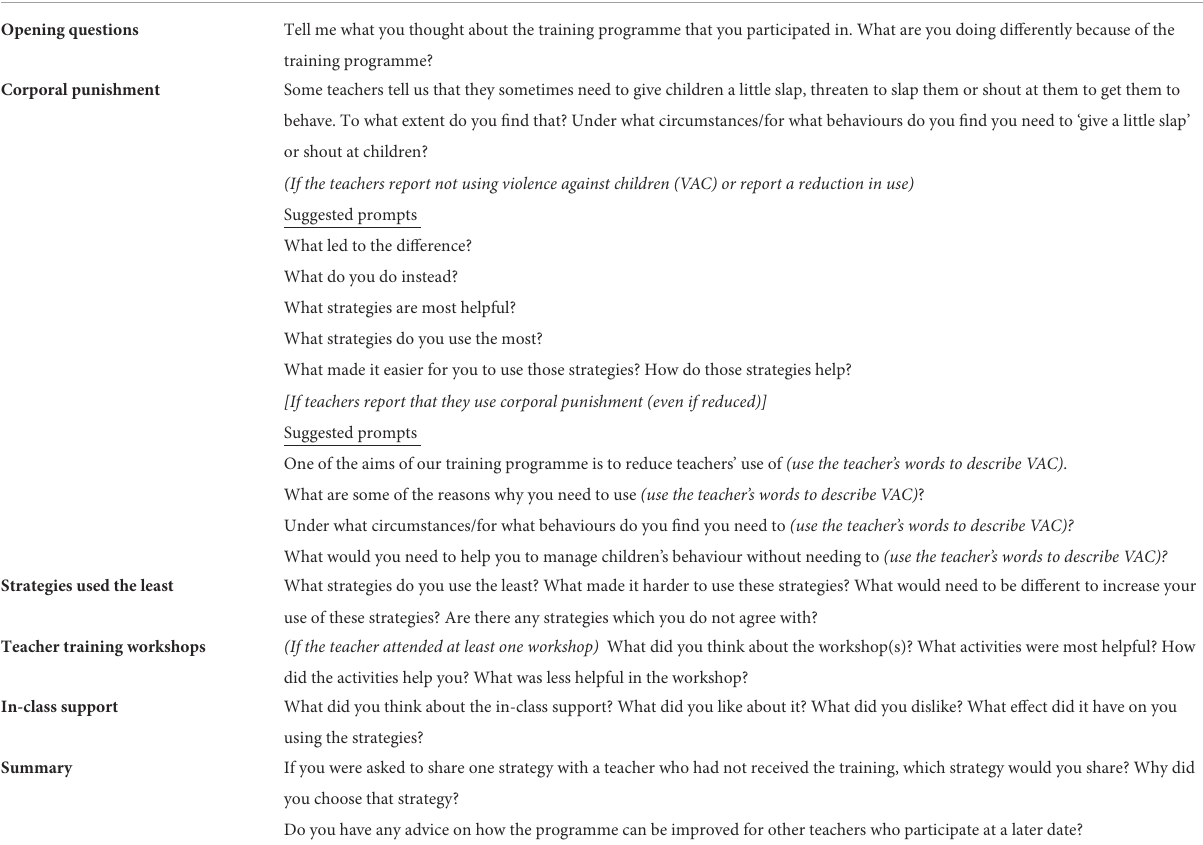
TABLE 2 Interview guide for in-depth semi-structured interviews. Topic Questions with suggested prompts